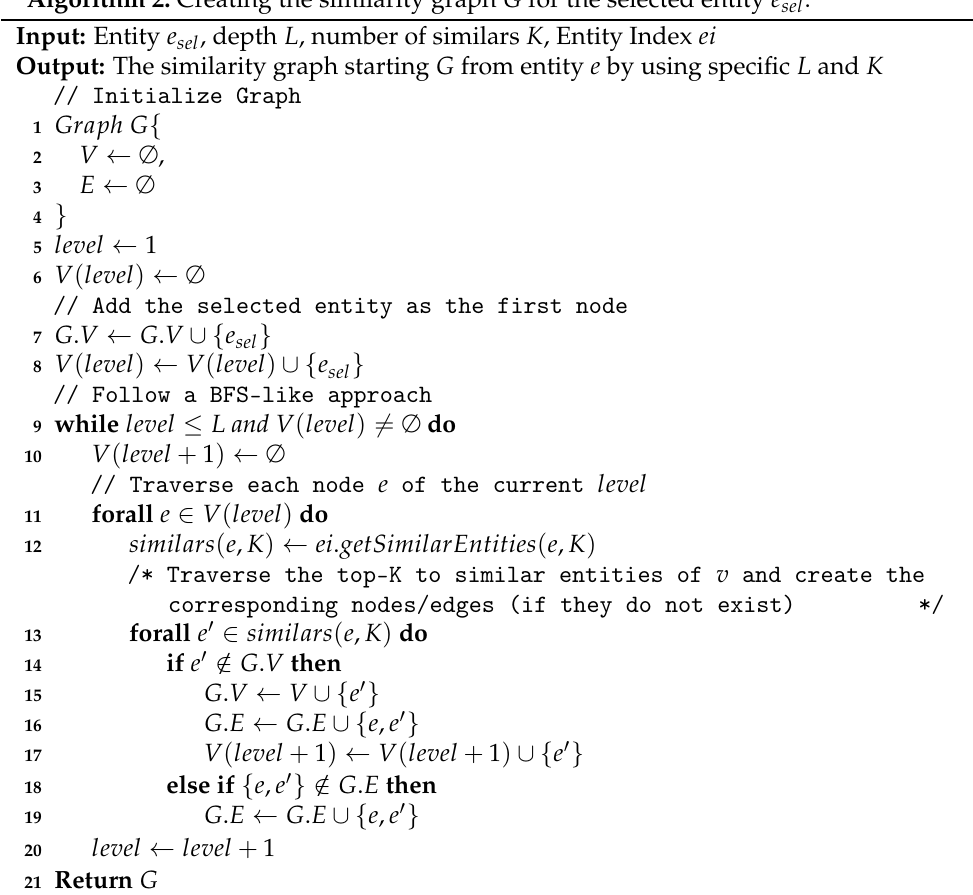
Algorithm 2: Creating the similarity graph G for the selected entity e sel